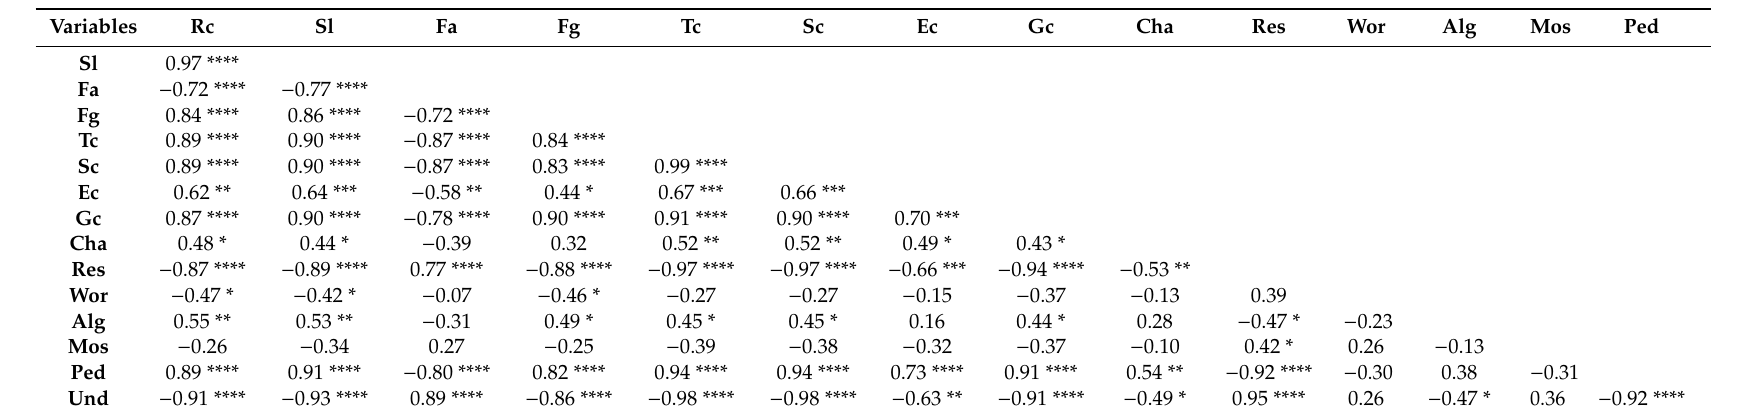
Table 2. Correlation (Pearson coe ffi cient) between seasonal runo ff coe ffi cient (Rc), seasonal soil loss (Sl), and soil surface features: Fa: free aggregates; Fg: free gravel; Tc: total crust; Sc: structural crust; Ec: erosion crust; Gc: gravel crust; Cha: charcoals; Res; residues; Wor: worm casts; Alg: algae; Mos: mosses; Ped: pedestals; Und: understory. All variables were measured in 2017 in Ban Kokngew, Luang Prabang Province, Lao People’s Democratic